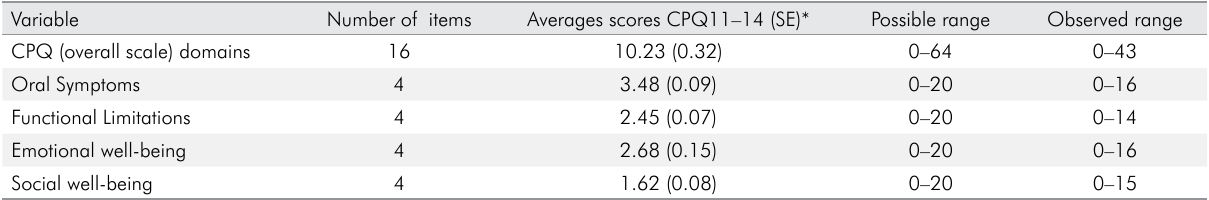
Table 2. Descriptive distribution of overall and domain-specific CPQ11–14 scores.